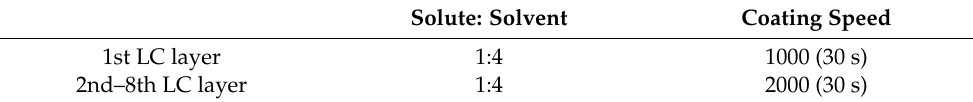
Table 1. Diluting ratio and coating speed for each layer.